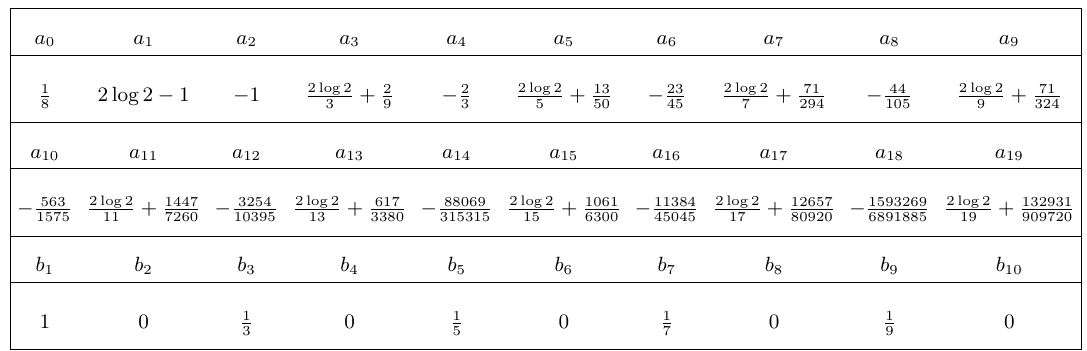
) following the ansatz given in eq. (C.13) and Table 3. Coefficients for the expansion of I (1 , x 2 2 obtained numerically by computing (C.14a), (C.14b). A factor g 8 N 2 / 2 9 π 6 has been removed for all coefficients. Guessing the closed form leads to the expression given in